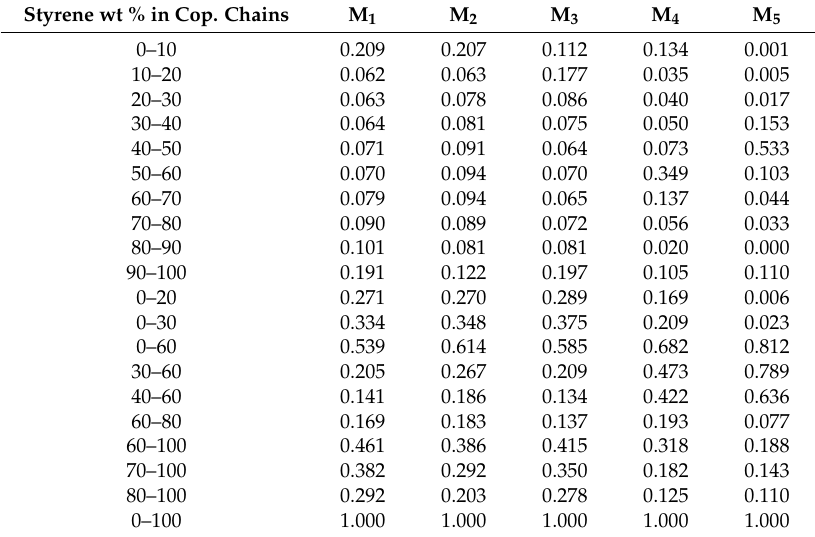
Table 2. Weight fraction of copolymer chains of FCC samples whose composition is within a specific interval. For codes, see Figure 1.